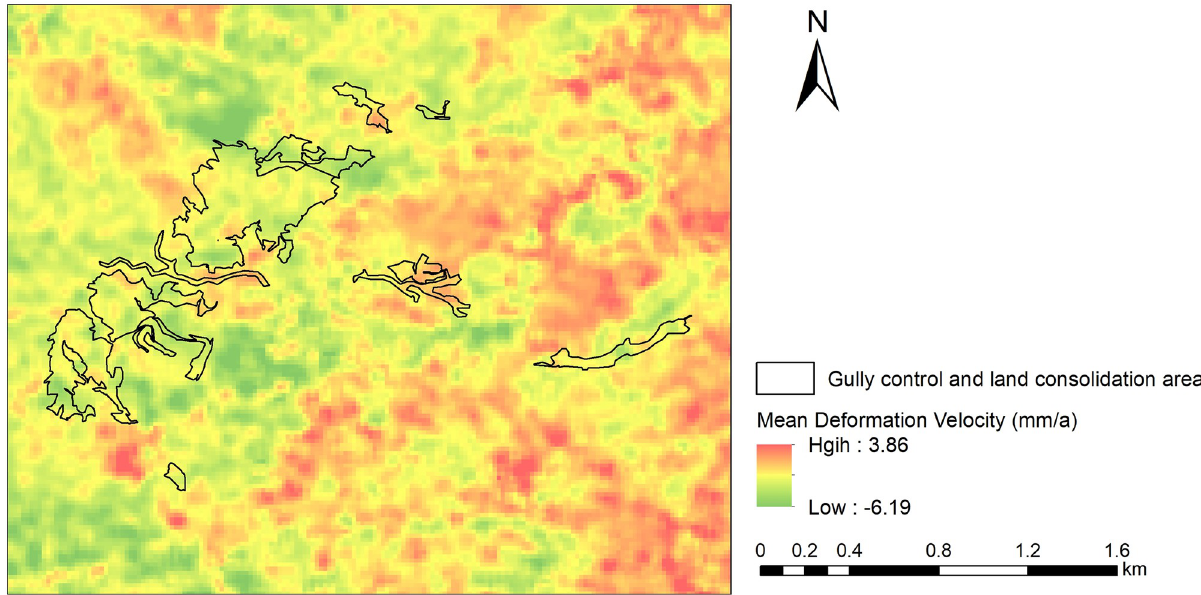
Fig 7. Mean Deformation Velocity of gully control and land consolidation area. Source: USGS Earth Resources Observatory and Science Center (https://www.usgs.gov/centers/eros).